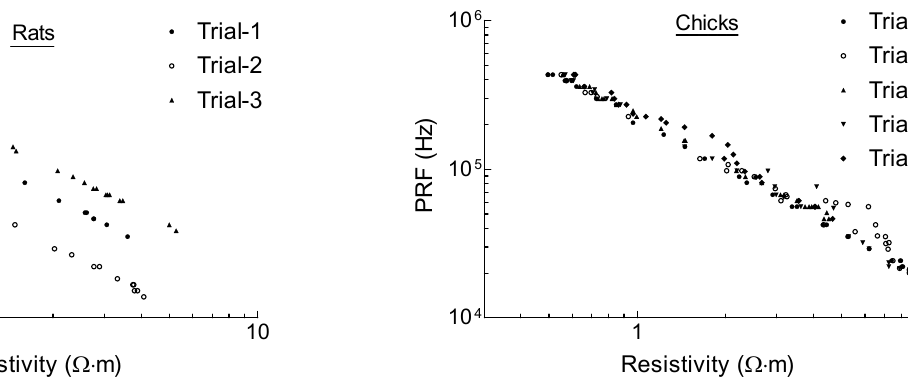
Fig. 9: PRF vs. resistivity plots for the three rat experiment trials. A large deviation for resistivity at a particular PRF between the trials was observed.